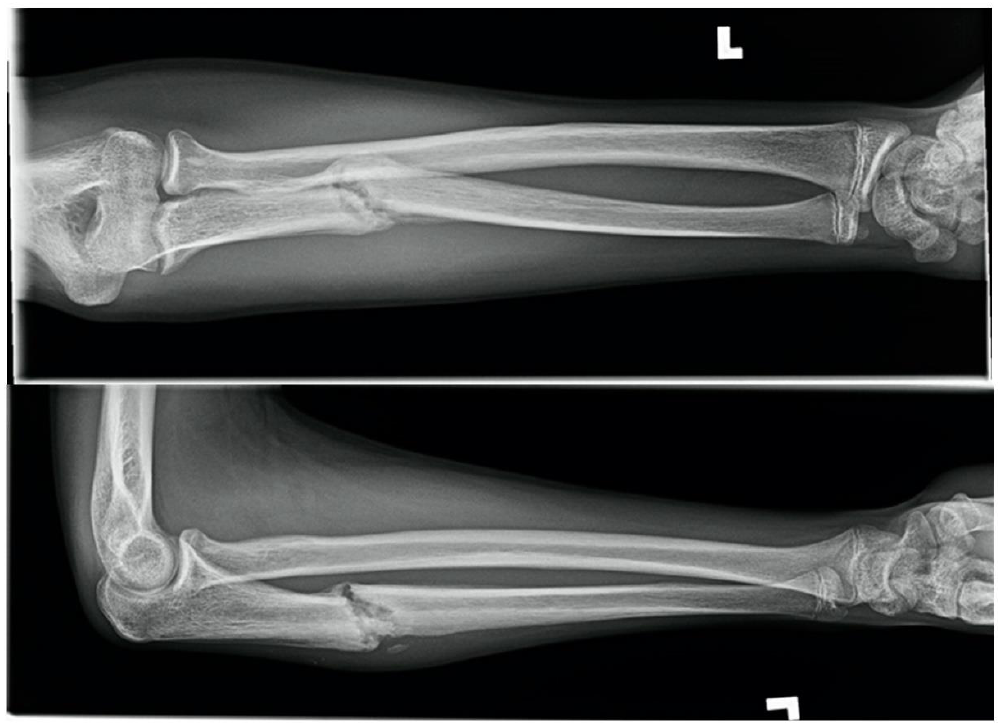
Figure 2. Eleven-week forearm radiographs demonstrating no union after Monteggia fracture-dislocation in a pediatric EC user.